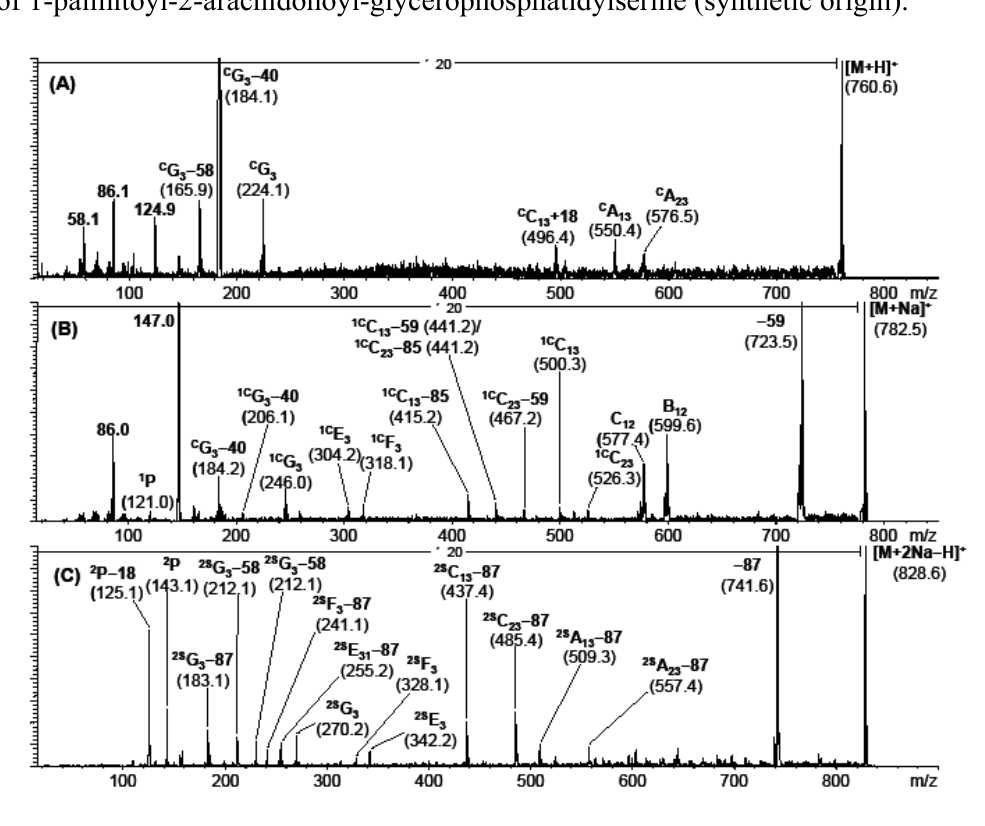
Figure 4. ( a ) High-energy CID-TOF/RTOF-spectrum of the [M+H] + precursor ion of 1-palmitoyl-2-oleoyl-glycero-phosphatidylcholine ( m/z 760.6); ( b ) of the corresponding [M+Na] + -precursor ion of 1-palmitoyl-2-oleoyl-glycerophosphytidylcholine ( m/z 782.5), both originating from commercial hen egg lecithine; and ( c ) of the [M+2Na − H] + precursor ion of 1-palmitoyl-2-arachidonoyl-glycerophosphatidylserine (synthetic